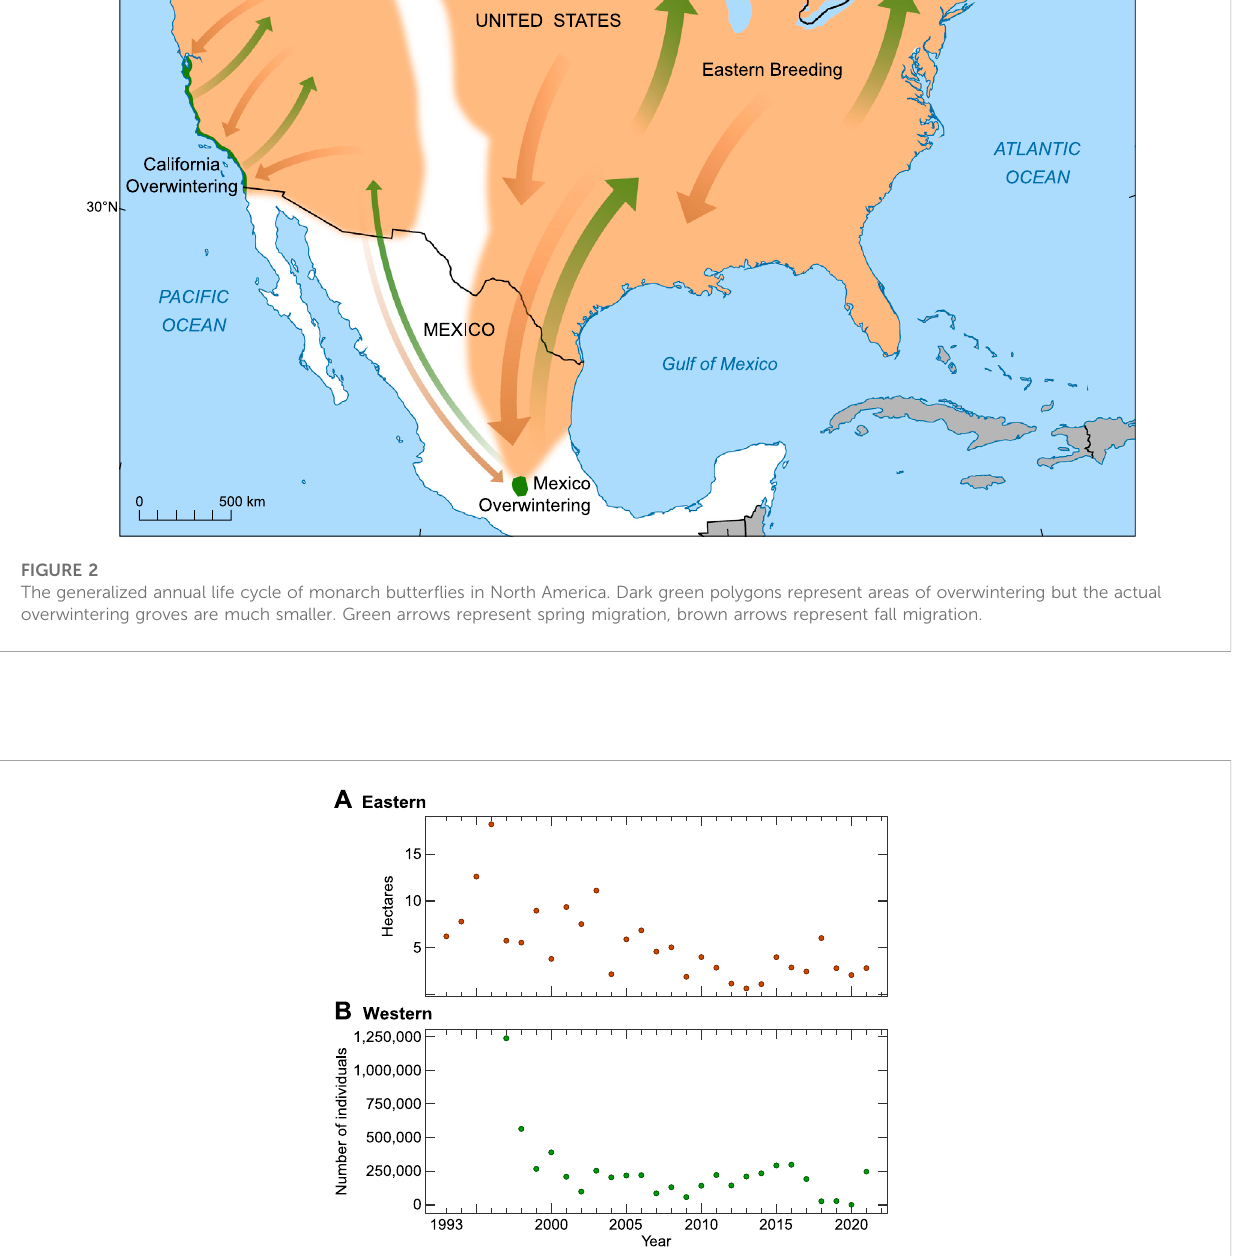
Frontiers in Environmental